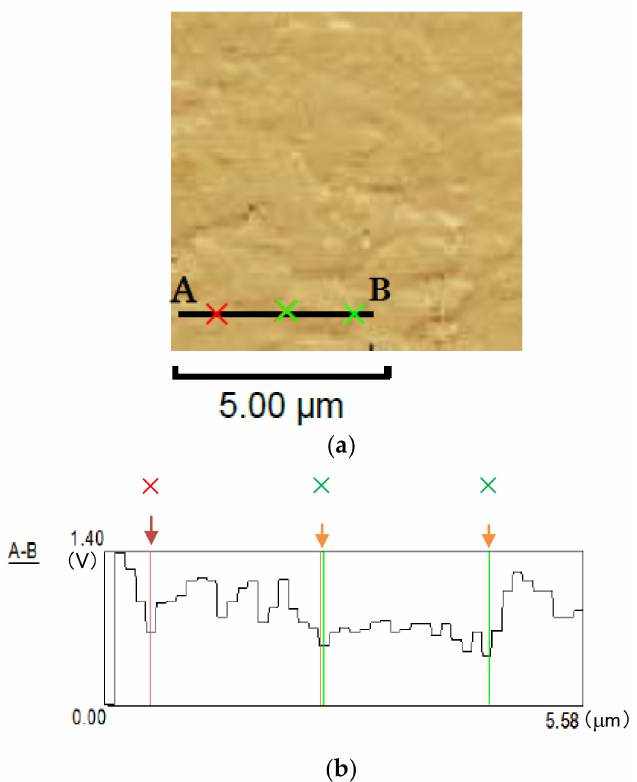
Figure 2. Determination of grain boundary position via AFM. ( a ) AFM image of replica film; ( b ) Change in excitation voltage (V) on line segment A–B. Three locations marked with × , × , and × in these figures correspond to grain boundaries existing on the line segment (from A to